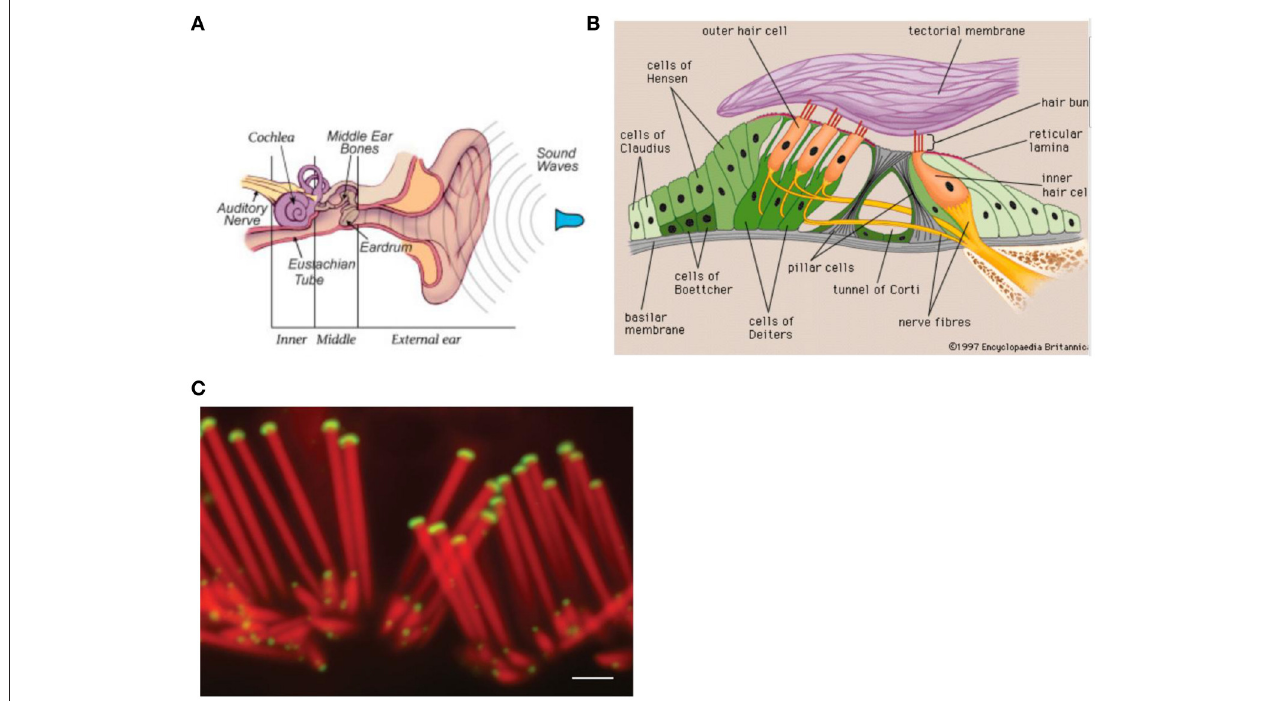
FIGURE 2 | Anatomy of the ear. Reprinted with permission from William E. Brownell © 2016. (B) Components of the inner ear. Reprinted with permission from © 2016 Encyclopedia Britannica. (C) Confocal micrographs of rat auditory hair cells. Scale bar: 1 µ m. The protein myosin XVa is localized to the stereocilia tips (Rzadzinska et al., 2004). Reprinted with permission from Rzadzinska et al. (2004) © 2016 Bechara Kachar.